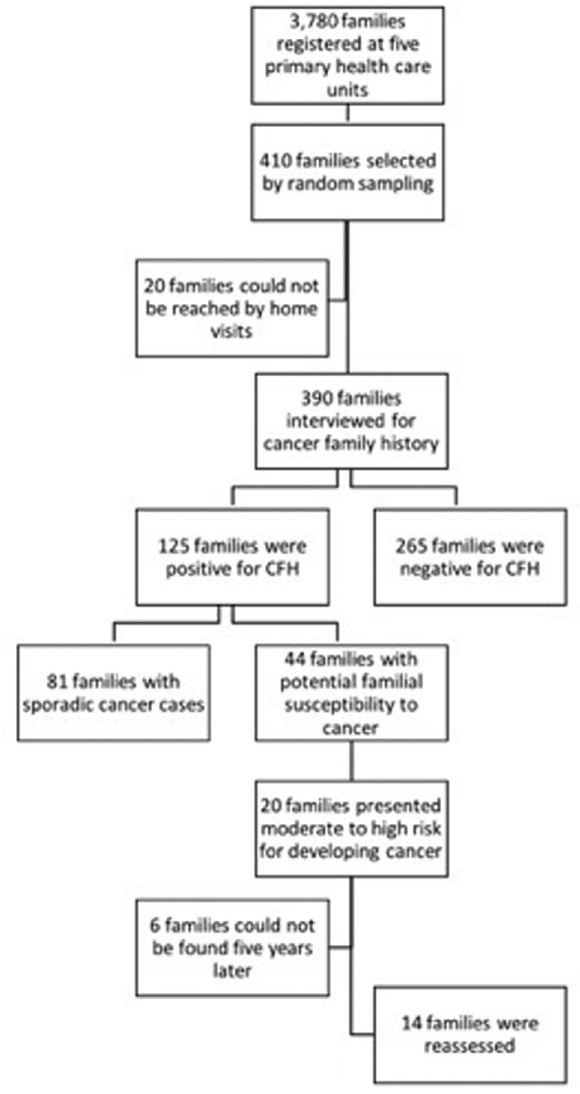
Figure 1 - Study flowchart including the number of evaluated families which relevant information were obtained in each step of the data collec- tion